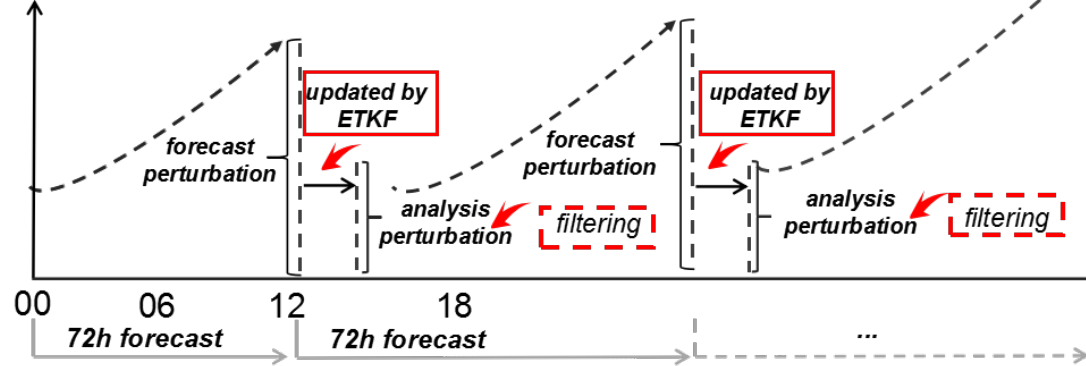
Figure 1. Process of the regional ensemble forecast system utilizing a filter process for the ensemble transform Kalman filter (ETKF) update cycle.